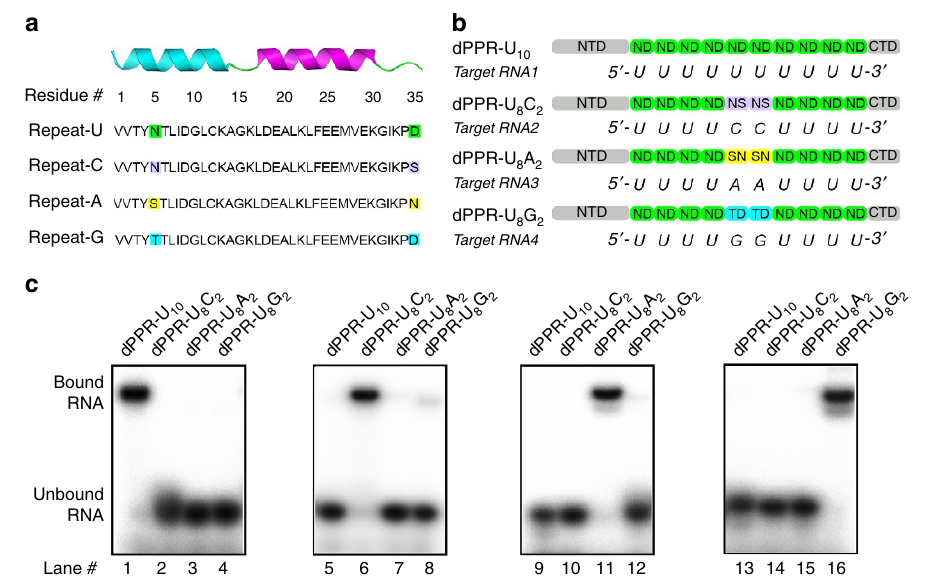
Figure 1 | Design of dPPR proteins with RNA-recognition specificity. ( a ) Sequence of dPPR motif containing 35 amino acids. The secondary structural elements of a typical PPR motif are shown above. PPR codes comprising two residues located at the 5th and 35th positions are labelled in distinct colours (‘ND’, ‘NS’, ‘SN’ and ‘TD’, which recognize uracil, cytosine, adenine and guanine, respectively, are coloured green, lilac, yellow and cyan, respectively). Single-letter abbreviations for the amino acid residues are as follows: A, Ala; C, Cys; D, Asp; E, Glu; F, Phe; G, Gly; I, Ile; K, Lys; L, Leu; M, Met; N, Asn; P, Pro; S, Ser; T, Thr; V, Val and Y, Tyr. ( b ) Schematic representation of dPPR-U 10 , dPPR-U 8 C 2 , dPPR-U 8 A 2 and dPPR-U 8 G 2 , and their targeting of specific RNA sequences. The shaded binary amino acids indicate PPR repeats with different codes. The NTD and CTD are from native PPR10. ( c ) Specific RNA target binding of dPPRs. In the RNA EMSA, 50nM purified dPPRs were mixed with 2nM 32 P-labelled RNA, respectively. The sequence of the RNA probe is listed below each panel. Fig. 1a is reprinted from, Shen et al. 28 with permission from Elsevier.